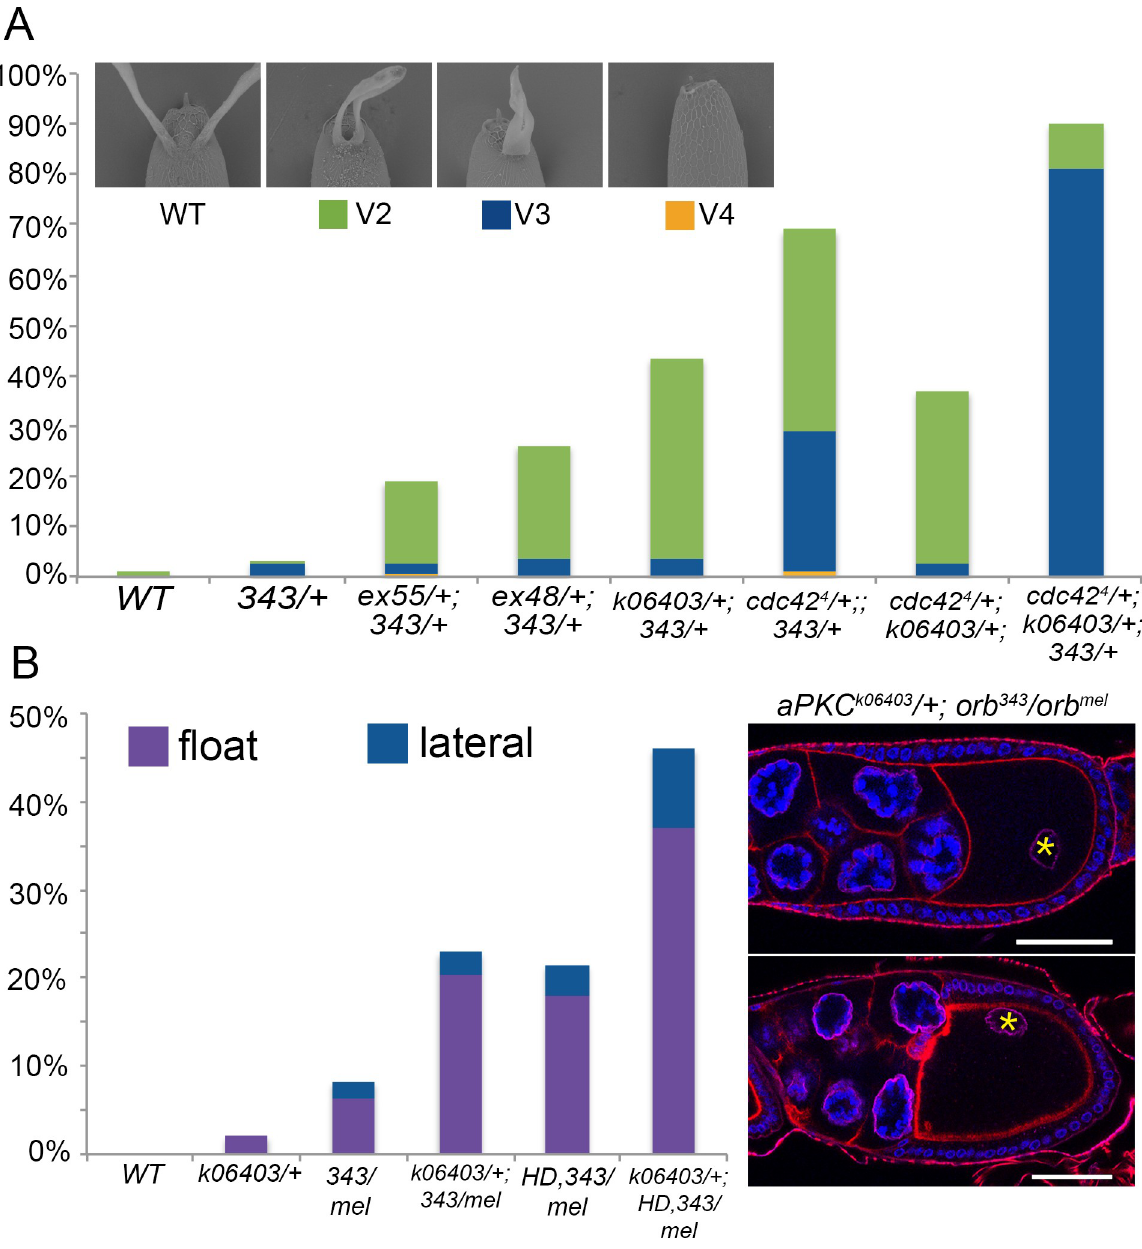
Fig 4. orb genetically interacts with aPKC for DV polarity and oocyte nucleus position. (A) Top: Dorsal appendage morphology: wild type and ventralized classes V2-V4 [73]. V2 is a reduction in the space between dorsal appendages, V3 is a fusion of the dorsal appendages and V4 is the most severe reduction in dorsal appendages. Bottom: Graph shows the percentage of ventralized eggs laid by wild type, orb heterozygotes ( 343/+) , double-heterozygotes between orb , aPKC alleles ( ex48 , ex55 and k06403 ), and cdc42 4 , double-heterozygotes between cdc42 4 and aPKC k06403 and triple heterozygotes of orb 343 , aPKC k06403 and cdc42 4 . Frequency of DV polarity defects for heterozygous controls not shown in the graph are listed in S1 Table. n = > 400 all genotypes. (B) Top: asterisks show mispositioned oocyte nuclei in aPKC k06403 /+; orb 343/mel (left shows a “float” position and right shows a lateral position). Scale bars 50 microns. Bottom: aPKC k06403 enhances orb mutant defects in oocyte nucleus position. Defects in aPKC k06403 /+ (2%, n = 50), aPKC k06403 /+; orb 343/mel (27%, n = 118) and aPKC k06403 /+; orb mel /HD , orb 343 (50%, n = 100). Scale bars are 50